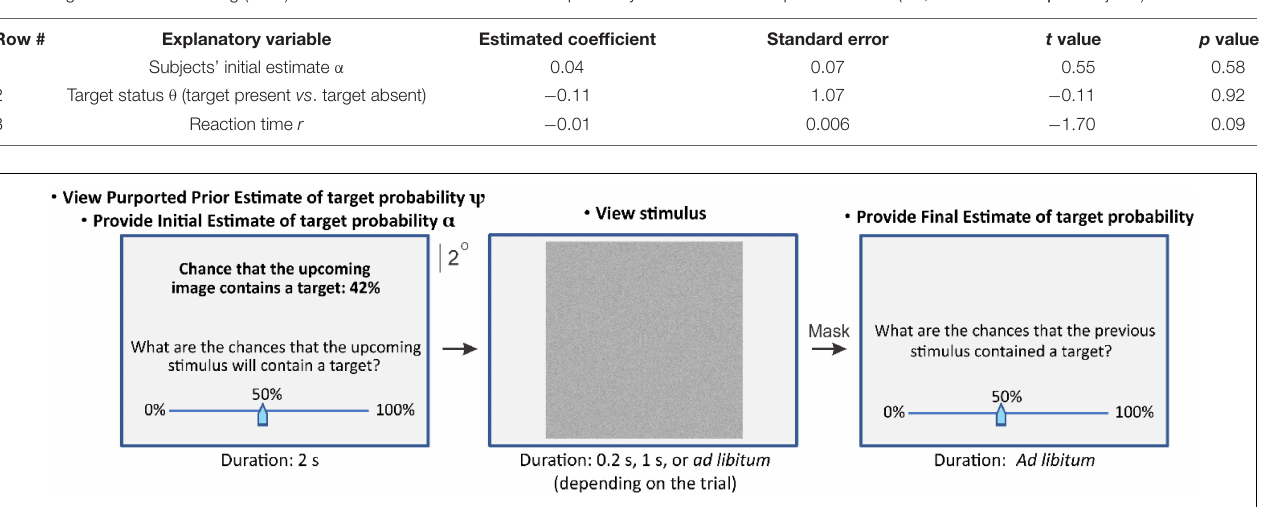
TABLE 4B | Contribution of the various explanatory variables to the final estimates γ when anchoring information was available in Experiment 2 (Conditions 1 and 2): Post hoc general linear modeling (GLM) of the contributions of the various explanatory variables to the response variable ( i.e ., final estimates γ of subjects).